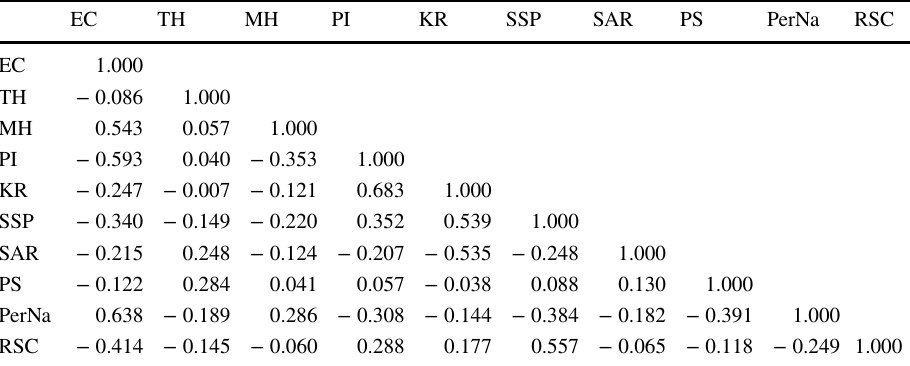
Table 4 Pearson correlation of